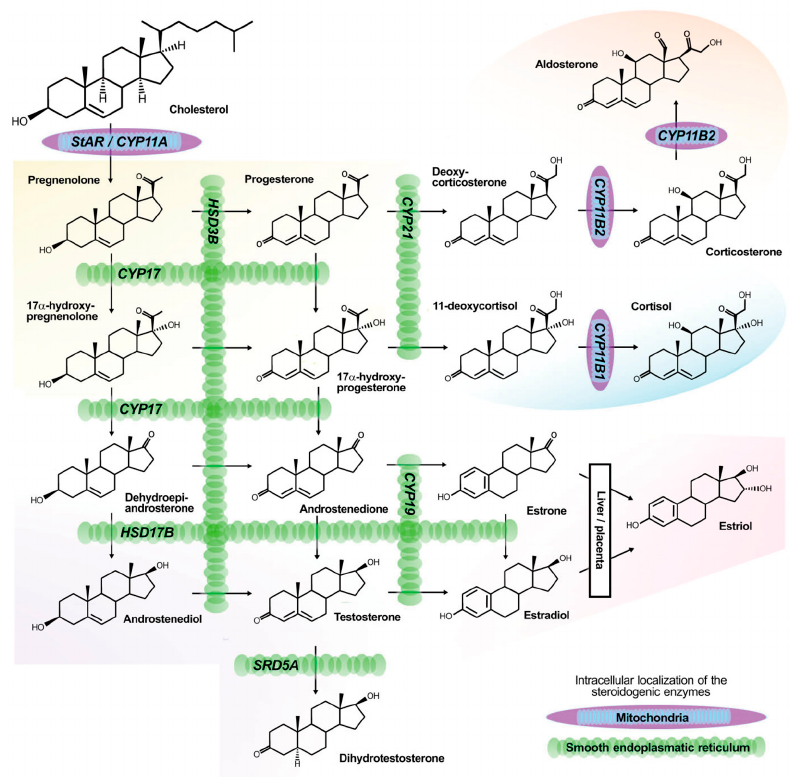
Figure 1. The steroidogenic pathways and their involved enzymes and products [32]. ATP1A1 encodes a sodium-potassium cotransporter (sodium/potassium-transport- ing ATPase subunit alpha-1), a protein whose essential function is to export sodium ions out of the cell and transport potassium ions into the cells. Genetic variants of somatic mu- tations in ATP1A1 include L104R, del100_104, V332G, and G99R [2,22,33]. ATP1A1 L104R loses ion selectivity and allows hydrogen ions to enter the cell, resulting in an increase in aldosterone production via cell depolarization or intracellular acidification [34]. ATP1A1 del100_104 is another genetic variant that causes loss of ion selectivity, and it has been reported that the influx of sodium ions, due to the loss of ion selectivity, causes cell depo- larization (Figure 2). The ATP2B3 gene [2,33] encodes a calcium transporter that consumes ATP and re- moves calcium from cells. L425_V426del and V426_V427del are the major genetic variants of somatic mutations detected in ATP2B3 genes, which cause the deletion of amino acids in the calcium ion-exporting subunit, resulting in the loss of intracellular calcium ion ex- port. As a result, the increased intracellular calcium ion concentration induces depolari- zation and activation of calcium signaling, which promotes the expression of genes in- volved in aldosterone synthesis (Figure 2). CACNA1D encodes an L-type calcium ion channel (CaV1.3), and somatic mutations such as G403R, S652L, F747L, and R990H have been reported [3,35–37], while G403R, S652L, F747L, and R900H mutations change calcium ion gating, and these phenotypes are a gain-of-function in calcium channels. CACNA1H encodes a T-type calcium ion channel